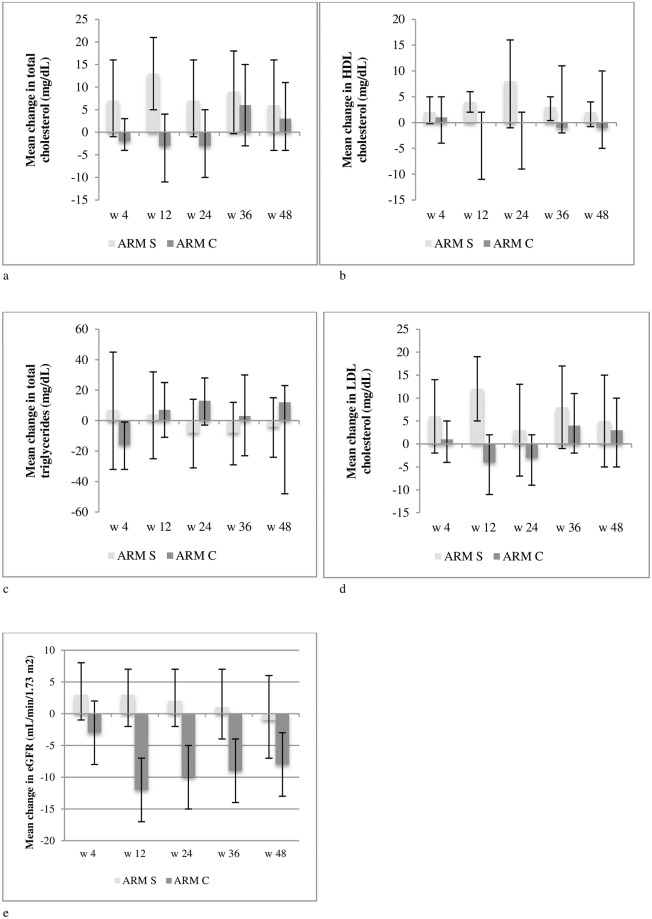
Evolution of (a-d) blood lipids and (e) renal function as by estimated GFR (CKD-EPI) over the 48 study weeks by randomization arm.Arm S = study arm (switch to maraviroc + darunavir/ritonavir); Arm C = continuation arm (continuation of previous 3-drug therapy).